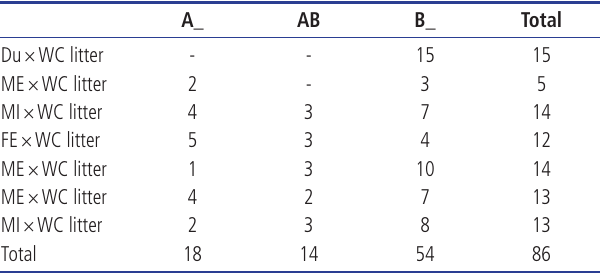
Table 2. Frequency of genotypes of OGT among the seven litters produced by the 7 F1 sows and 2 WC boars 1) A_ AB B_ Total Du×WC litter - 15 15